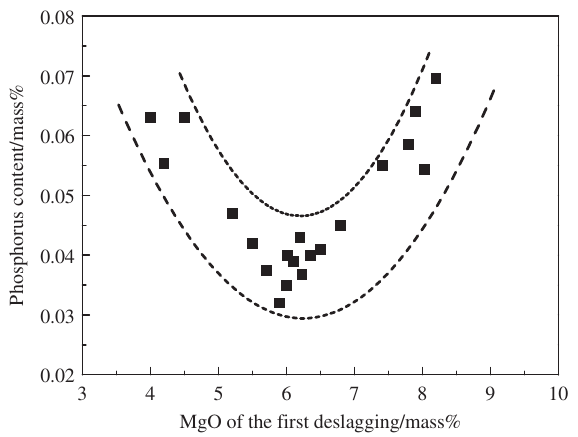
Figure 10: Effect of the MgO content in slag at the first deslagging on the phosphorus content in bulk metal.